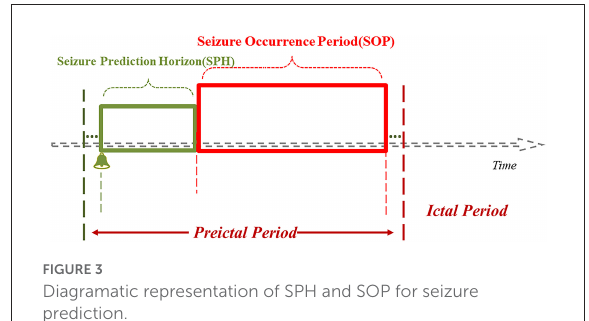
FIGURE3 Diagramatic representation of SPH and SOP for seizure